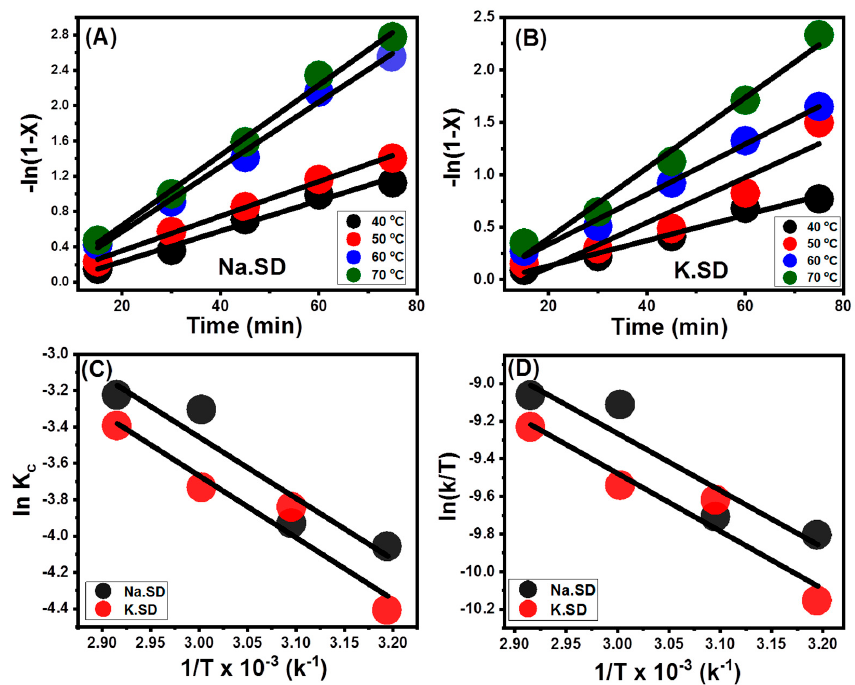
Figure 5. Results of the fitting of the biodiesel yields of Na.SD and K.SD with the pseudo-first-order kinetic model ( A , B ), with the Arrhenius equation ( C ), and with the Eyring–Polanyi equation ( D ).